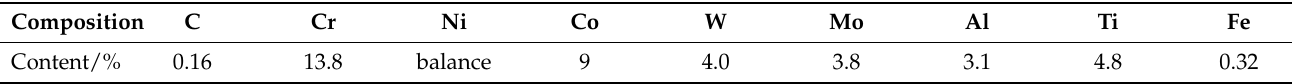
Table 2. Composition of Hastelloy X (wt.%).